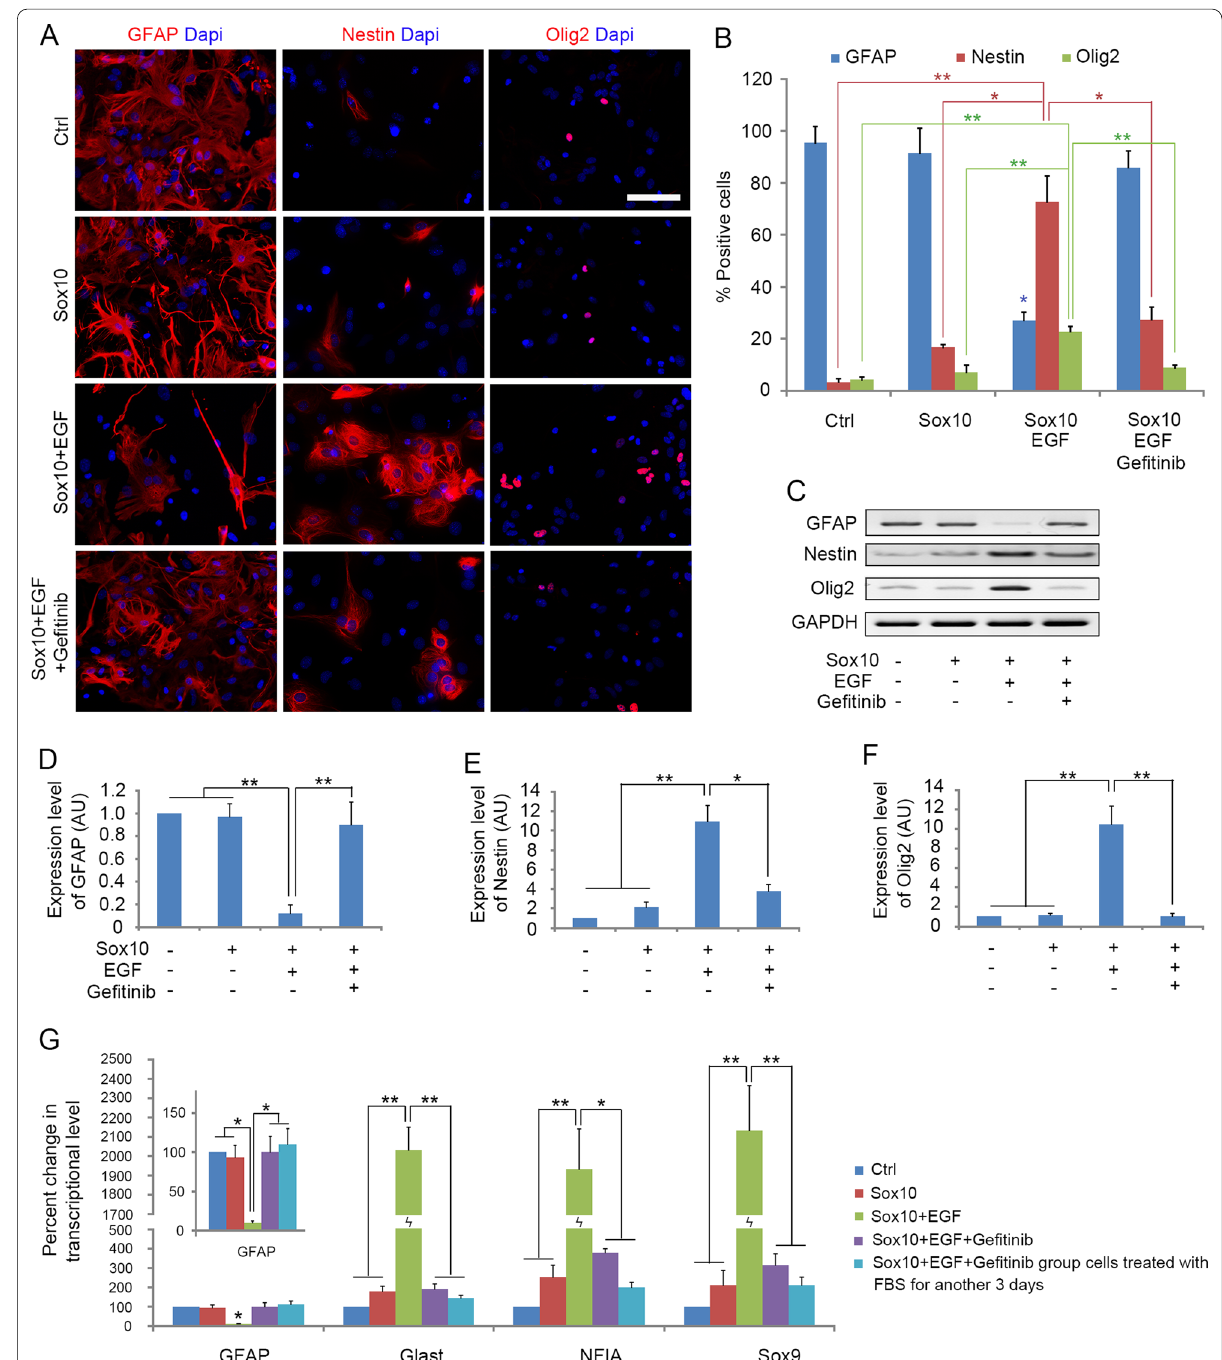
Fig. 2 EGF promotes astrocyte dedifferentiation. A Immunostaining of cells with GFAP, Nestin and Olig2 antibodies 5 days after transdifferentiation. B Quantification of immune-positive cells in the four cultures. C Western blotting analysis of GFAP, Nestin and Olig2 on d5 during the transdifferentiation process. D – F Quantitative analysis of GFAP, Nestin and Olig2 proteins expression in the four cultures on d5, respectively, histograms express results in arbitrary units, taking Ctrl cells values as 100%. G Quantitative RT-PCR analysis of the expression level of GFAP, Glast, NFIA and Sox9 in the four groups on d5 during the transdifferentiation process and Sox10 EGF Gefitinib group cells treated with FBS for another + + 3 days. Statistical analyses are presented as Mean SD, n 3. **P < 0.01, ***P < 0.001. Scale bars, 50 ± =